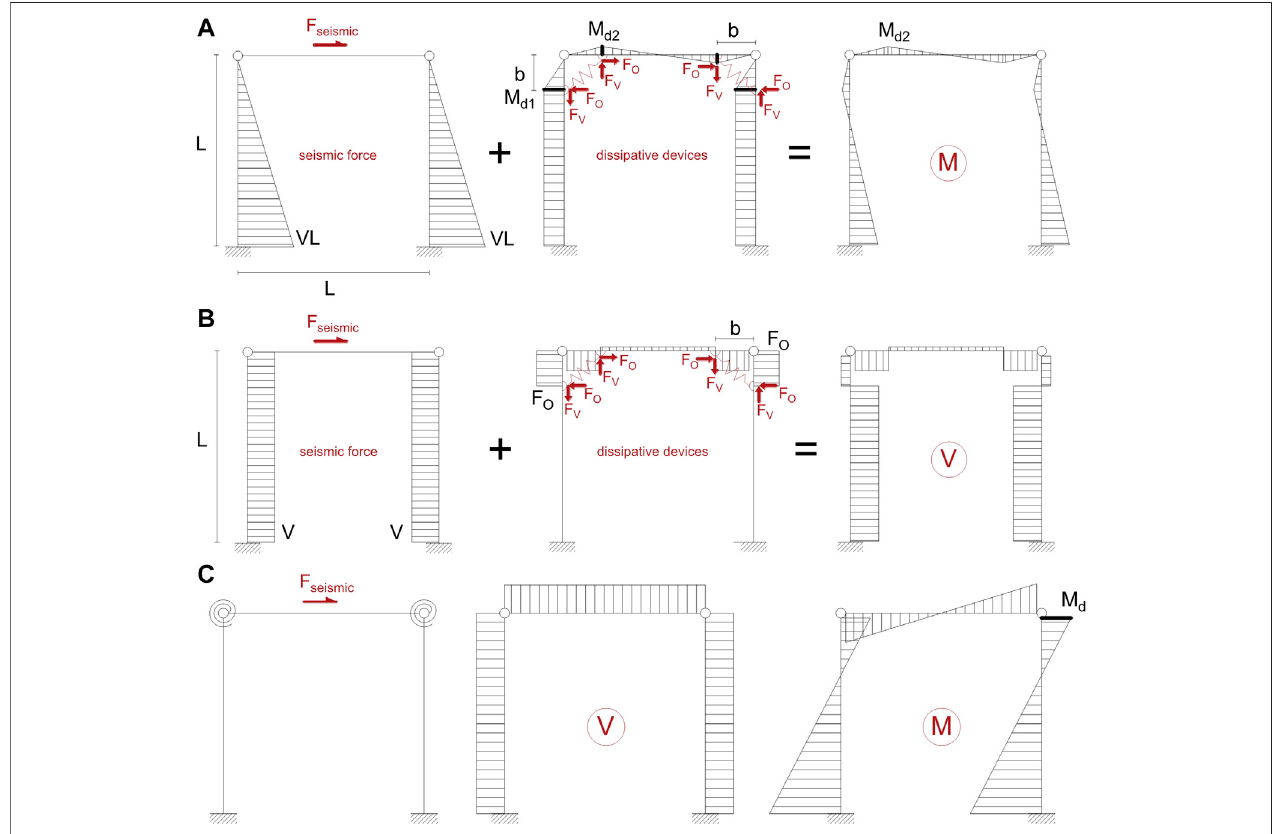
FIGURE 8 | Contribution to the bending moment (A) and shear (B) diagram of the device in its actual position and in the case of idealized frame with lumped rotational springs at the joints (C) .